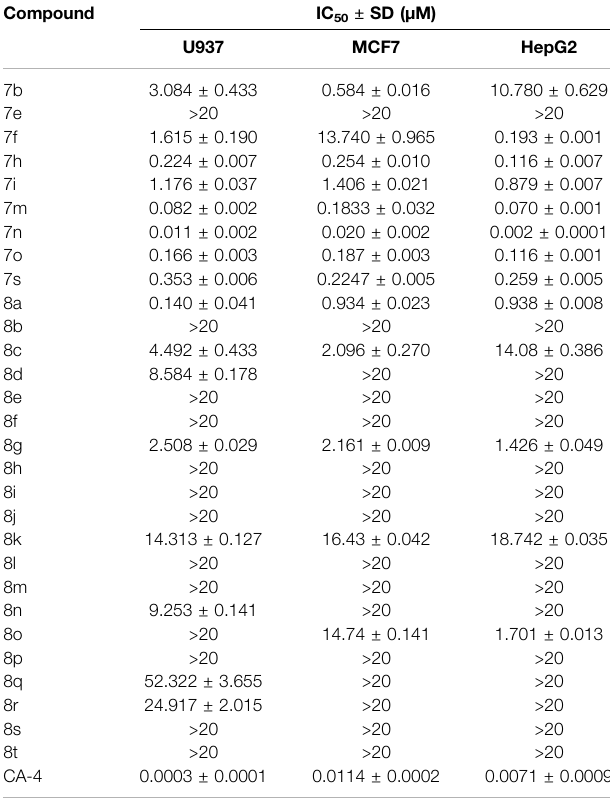
TABLE 2 | Evaluation of in vitro antiproliferative activity of α -methyl chalcones (7) and α -nitrile chalcones (8) (IC 50a